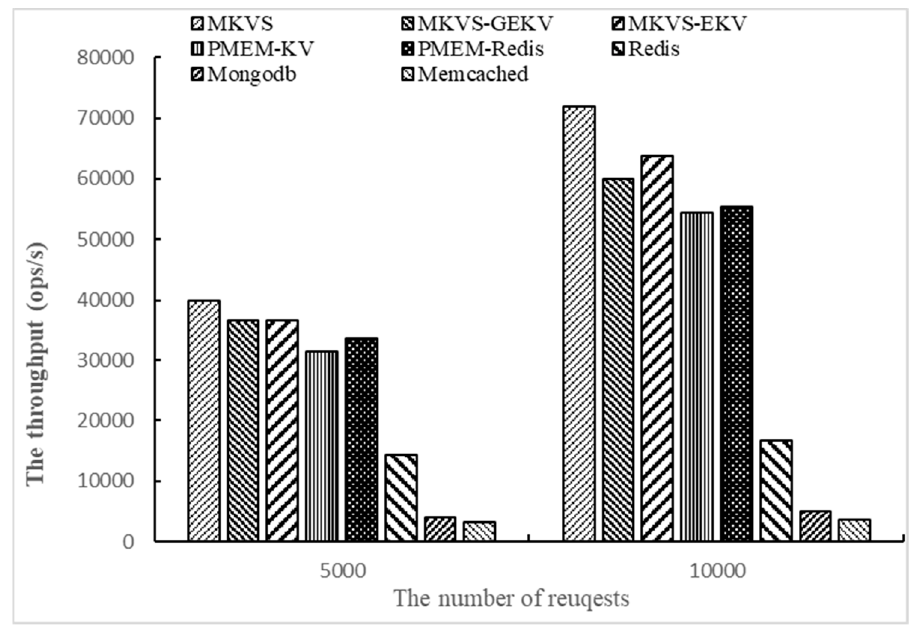
Figure 4. The throughput of changing the number of access operations with Workloadb.